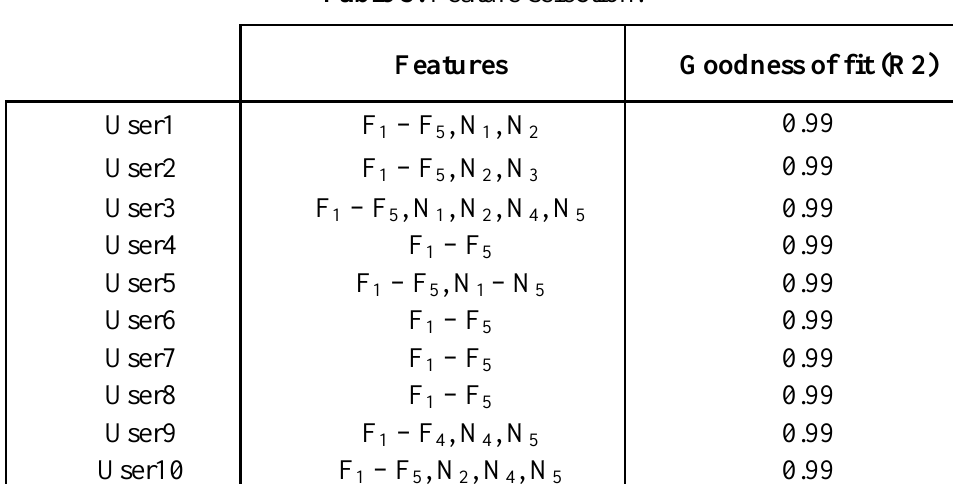
Table 3. Feature selection.